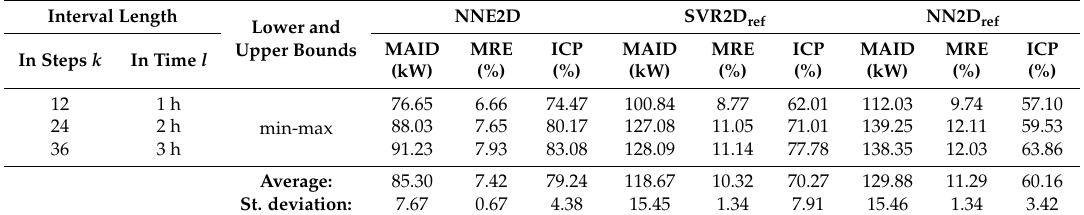
Table 7. Comparison of prediction accuracy for NNE2D, SVR2D ref and NN2D ref .